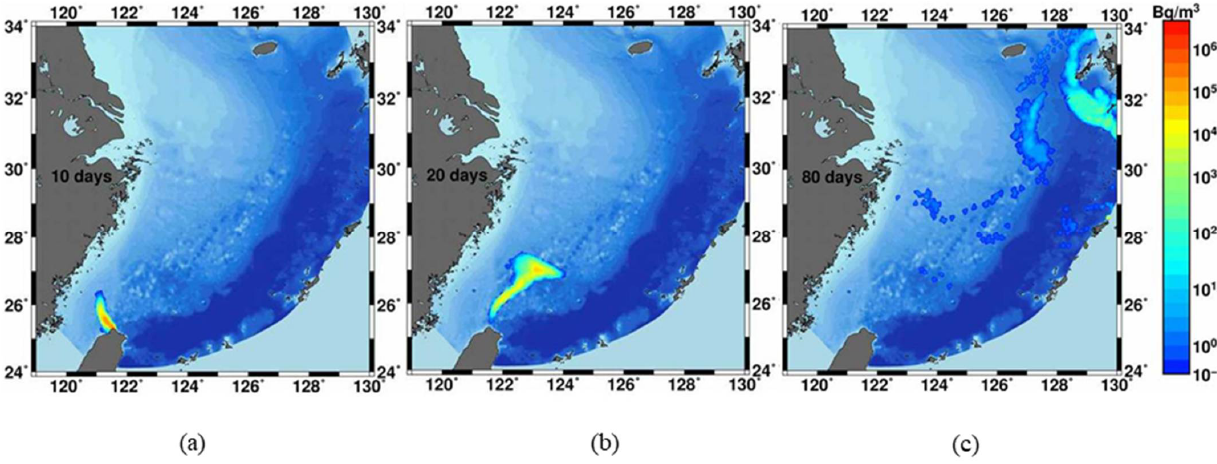
Figure 17. Surface concentration of 137 Cs after 10 days ( a ), 20 days ( b ), and 80 days ( c ) after beginning of release from the Kuosheng NPP.